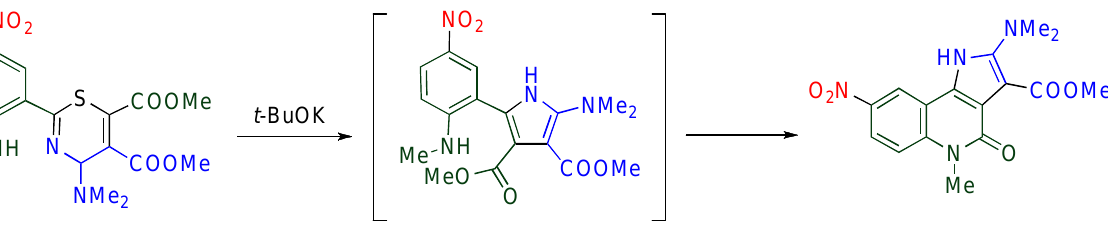
Scheme 5. Ring transformation of